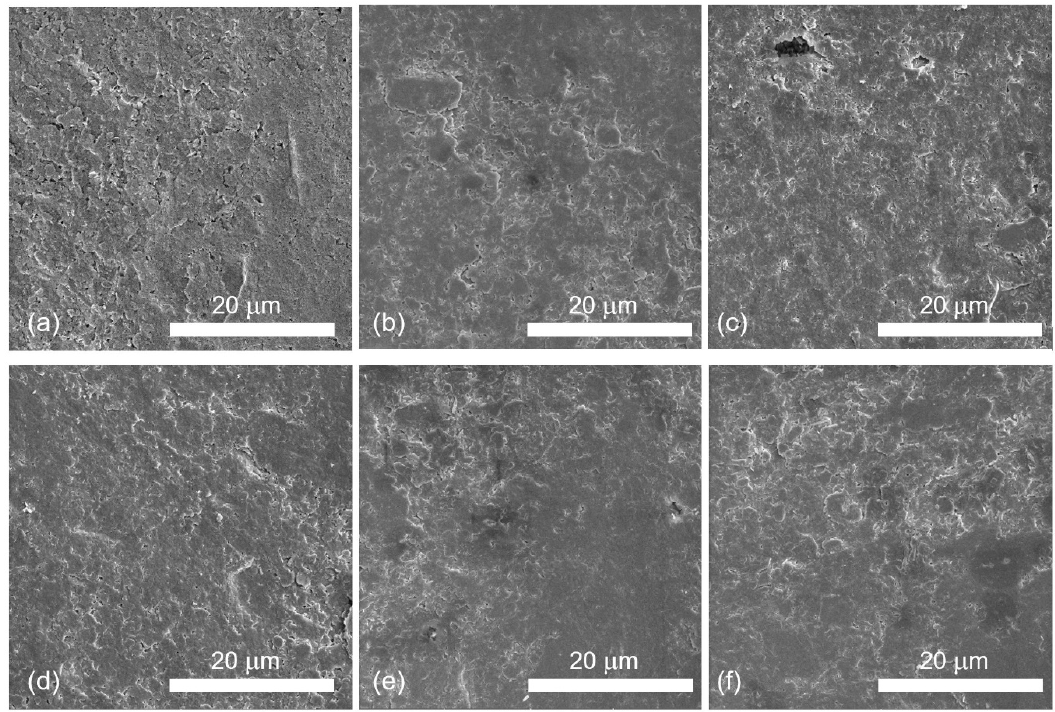
Figure 5. SEM micrographs of untreated ( a ) and 0.5 mL silicone-coated paper plasma pre/post-treated in air for 0.5/0 s ( b ), 0.5/0.5 s ( c ), 0.5/5 s ( d ), and 5/5 s ( e ) and in nitrogen for 0.5/0.5 s ( f ) (scale: 20 μ m).